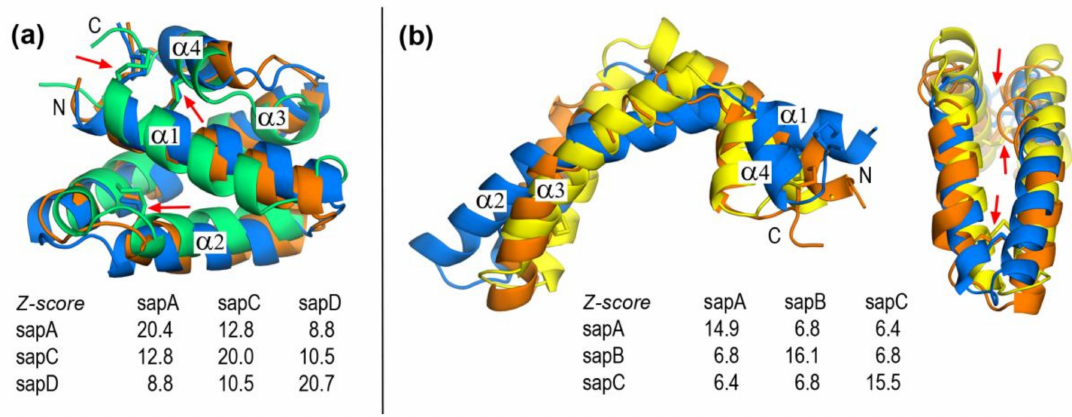
Figure 1. Structural alignment of human saposins obtained with DALI. ( a ) Closed conformations of saposin A (chain A in 4UEX, blue), saposin C (2GTG, orange), and saposin D (chain A in 2RB3, green). ( b ) Open conformations of saposin A (4DDJ, blue), saposin B (chain A in 1N69, yellow), and saposin C (conformation 1 in 1SN6, orange). DALI Z-score matrices of pairwise structural similarities are also shown. Red arrows indicate three conserved interhelical disulfide